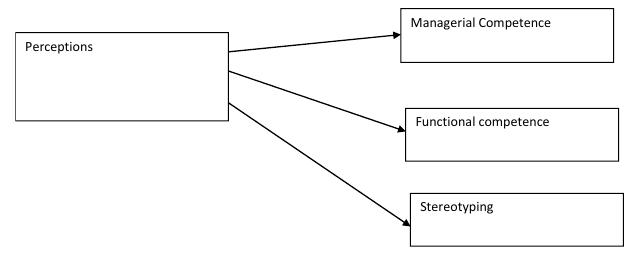
Figure 1: The conceptual model of the